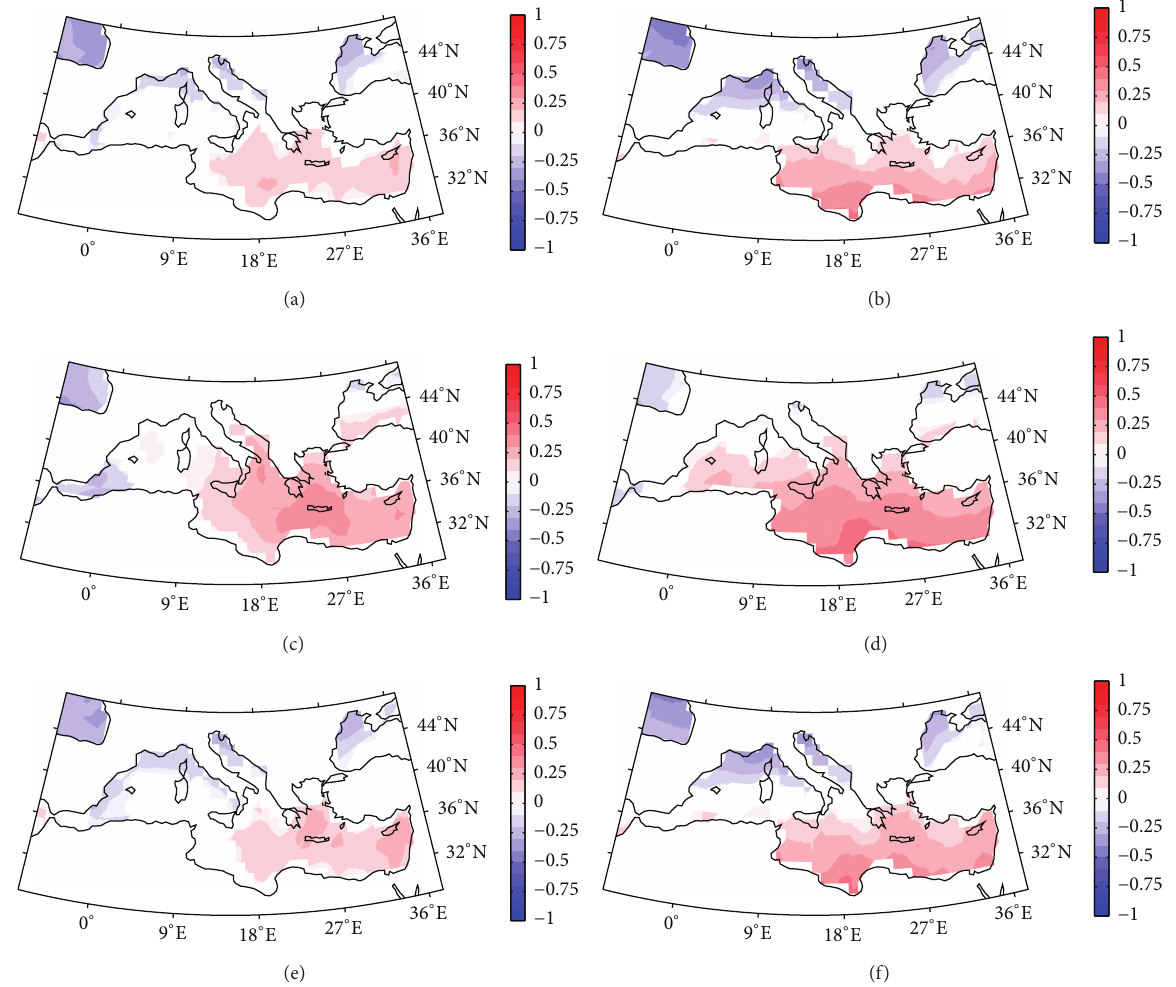
Figure 4: (a), (c), and (e) Correlations between detrended monthly mean latent heat flux and detrended Azores High sea level pressure, Azores High longitude, and NAO index; (b), (d), and (f) correlations between detrended monthly mean sensible heat flux and detrended Azores High sea level pressure, Azores High longitude, and NAO index, DJF 1958–2011. Only correlations which are significant at 𝑃 = 0.05 are